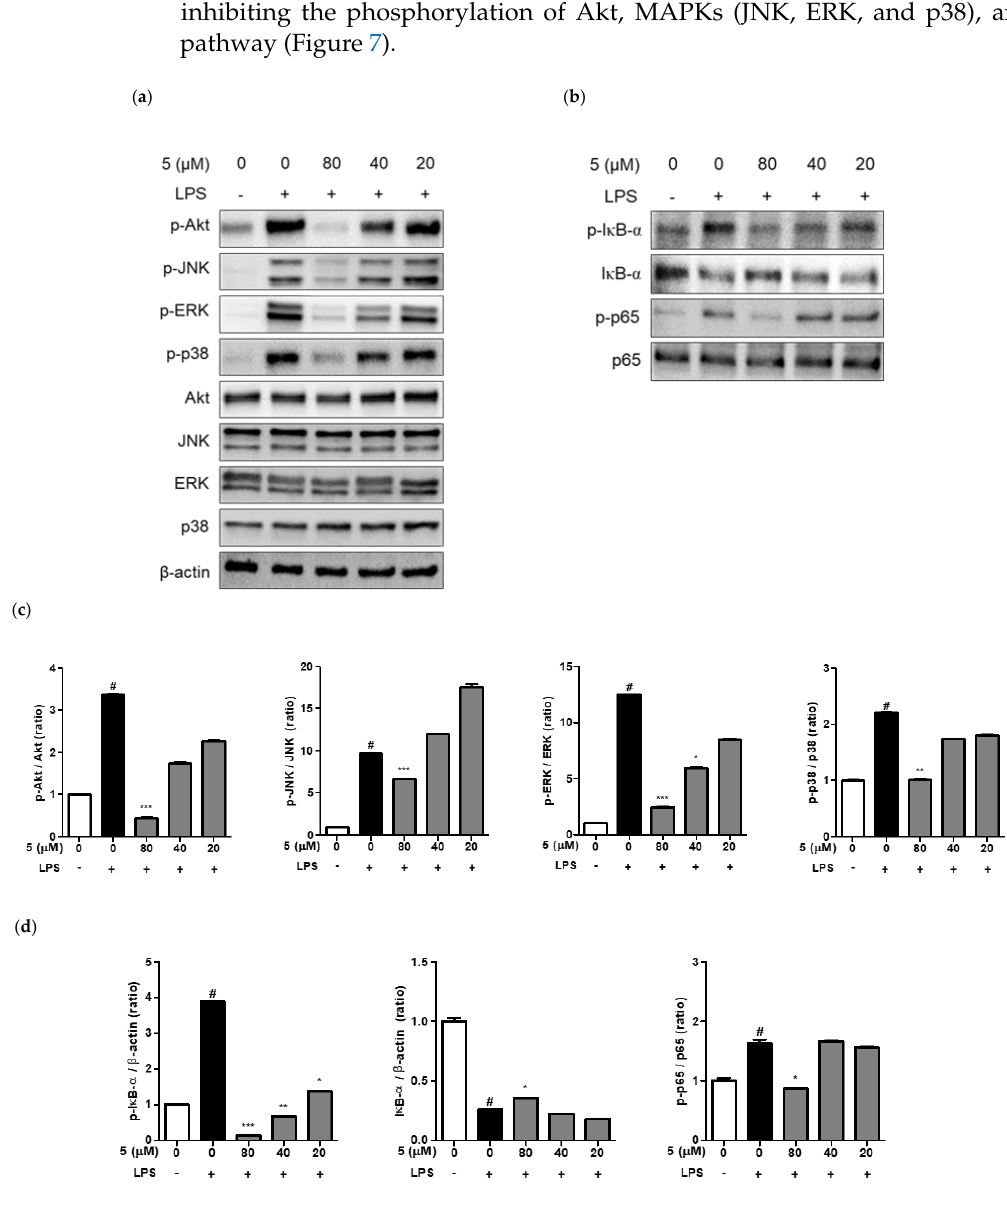
Figure 7. Effects of 3-(3-hydroxyphenyl)-indolin-2-one on phosphorylation of Akt, MAPKs proteins, and NF- κ B pathways in RAW264.7 cells; (-): non-treated group, (+): LPS-treated group. ( a , b ) RAW264.7 cells (2.0 × 10 6 cells/6-cm dish) treated with the indicated concentrations of 3-(3-hydroxyphenyl)-indolin-2-one (20–80 µ g/mL) for 2 h and then stimulated with lipopolysaccharide (LPS; 500 ng/mL) for 30 min. Whole-cell lysates were immunoblotted with the specific antibodies indicated on the left side of each panel. The level of β -actin was measured as an internal loading control. ( c ) pAKT, pJNK, pERK, and pp38 protein levels were validated and total protein levels were obtained using the ImageJ software. ( d ) pIκB, IκB, and p65 protein levels were validated using the Image J software. β -actin was used as an internal control. Data are presented as the mean ± standard deviation (SD) of three independent experiments. White bar: non-treated group, black bar: LPS treated group, gray bar: sample treated group. # p < 0.0001 vs. the control group. *** p < 0.0001, ** p < 0.001 or * p < 0.05 vs. the LPS group.